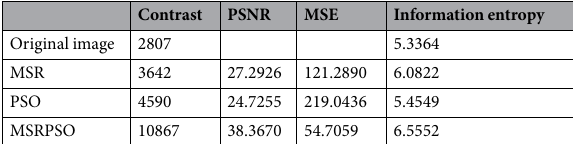
Table 1. Quality evaluation of MSR and the nonlinear